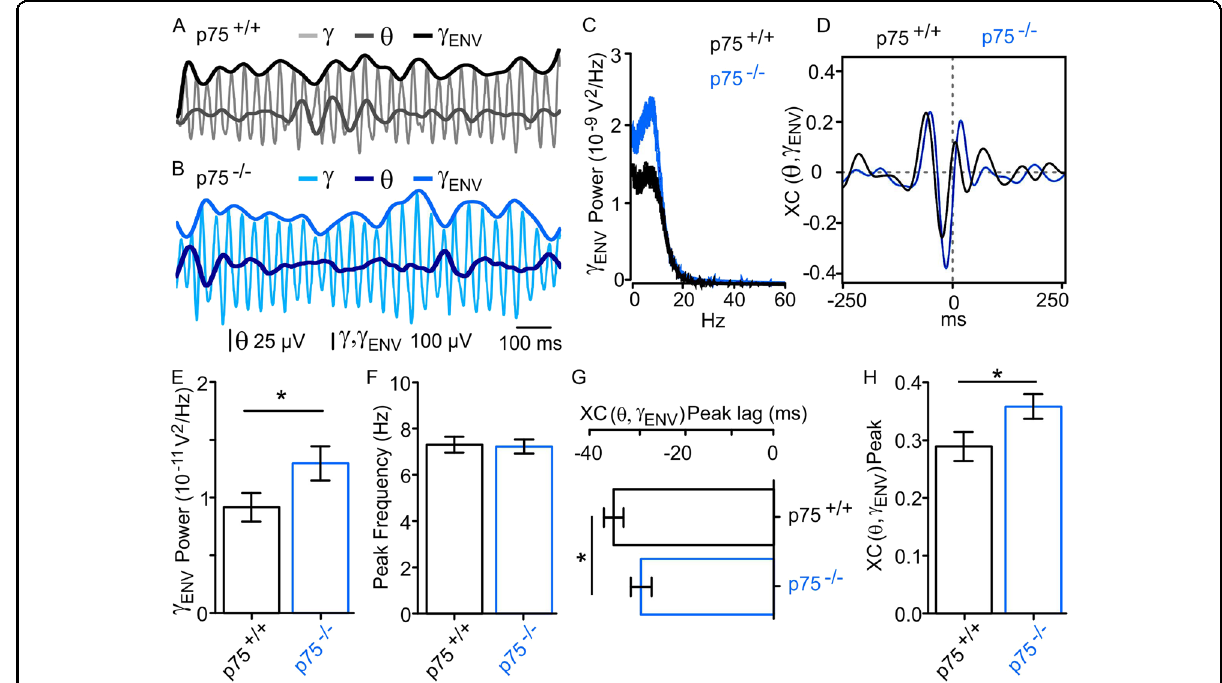
Fig. 2 p75 NTR ablation strengthens gamma nesting within the theta rhythm. A , B Representative traces of CCh-induced LFPs in the same experimental conditions as in Fig. 1 showing gamma ( γ ) and underlying theta ( θ ) oscillations. An envelope signal was adjusted to the amplitude of each γ peak ( γ ENV , see “ Methods ” ) on recordings from p75 + / + ( γ ENV : top black trace; γ : gray; θ : dark gray) and p75 − / − ( γ ENV : top blue trace; γ : blue; θ : dark blue) mice. C Representative power spectra of the γ ENV oscillation of p75 + / + (black) and p75 − / − (blue), showing that this oscillation falls within the frequency range of θ rhythm (5 – 10 Hz) in both mouse strains with similar peak frequency and increased power in p75 − / − mice. D Cross- correlation function of θ with γ ENV (XC( θ , γ ENV )) obtained from the same data as in ( A , B ) re fl ects the coincidence of γ bouts within the θ range with the trough of θ as a central prominent negative peak close to zero. The slight lag shift of XC( θ , γ ENV ) peak in p75 + / + (black) compared to p75 − / − (blue) mice reveals the difference of θ − γ ENV phase locking quanti fi ed in ( F ) similar to that observed in γ − θ phase locking (refer to Fig. S4). E Power of γ ENV in the θ frequency band shows a signi fi cant increase in the amplitude modulation of p75 − / − – gamma oscillations (p75 + / + : 9.2 ± 1.2 × 10 − 11 V 2 , n = 24 vs. p75 − / − : 13 ± 1.5 × 10 − 11 V 2 , n = 31, p = 0.0429). F Peak frequency of the spectra as in ( C ) from all slices recorded showing that the amplitude modulation of γ is oscillating within the θ range in both mice strains (p75 + / + : 7.3 ± 0.3 Hz, n = 24 vs. p75 − / − : 7.2 ± 0.3 Hz, n = 31, p = 0.3988). G Quanti fi cation of the XC( θ , γ ENV ) peak lag in both mouse strains showing the phase relationship between θ and γ ENV signals (p75 + / + : − / − mice also indicates a stronger modulation of − 34.8 ± 6.1 ms, n = 24 vs. p75 − / − : − 28.8 ± 4, n = 31; p = 0.0332). H Larger XC( θ , γ ENV ) peak in p75 γ amplitude by the underlying θ rhythms in p75 − / − mice (p75 + / + : 0.29 ± 0.03, n = 24 vs. p75 − / − : 0.36 ± 0.02, n = 31; p = 0.0206). Data are presented as mean ± SEM. * P < 0.05 compared to p75 + / +